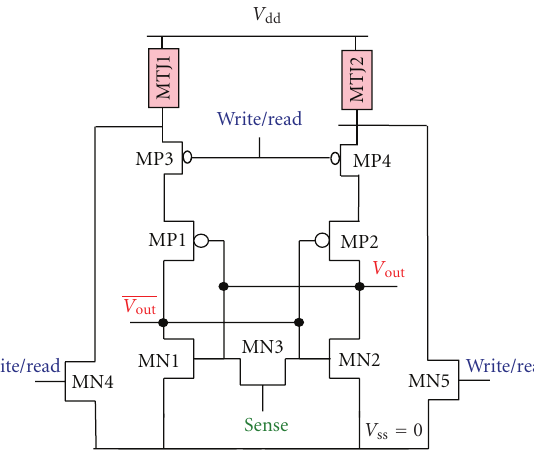
Figure 5: First read/write structure for a TAS-MRAM